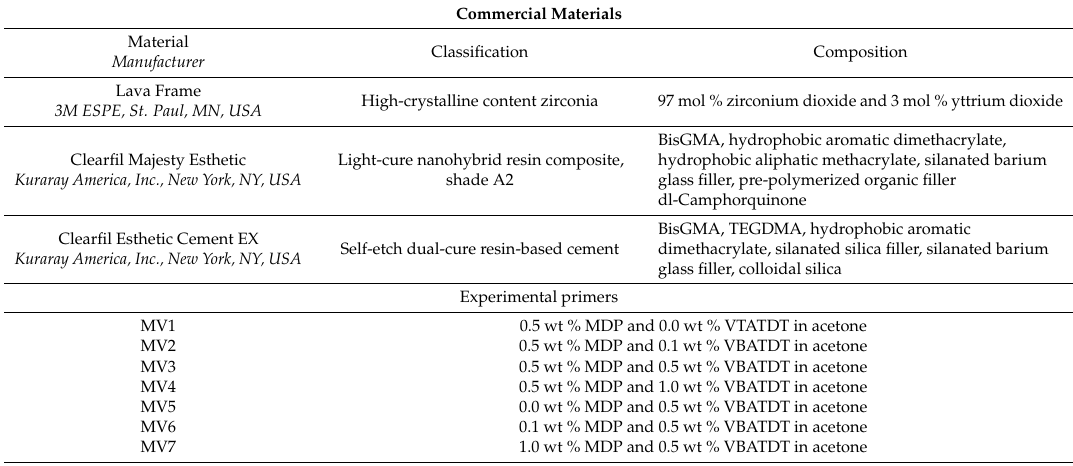
Table 1. Names, formulation, and additional information about the materials